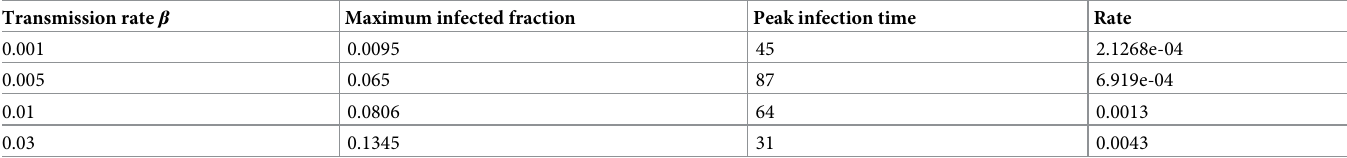
Table 2. Table shows maximum infected fractions of cows, peak infection time, and rate at which that maximum is attained for a homogeneous network. Transmission rate